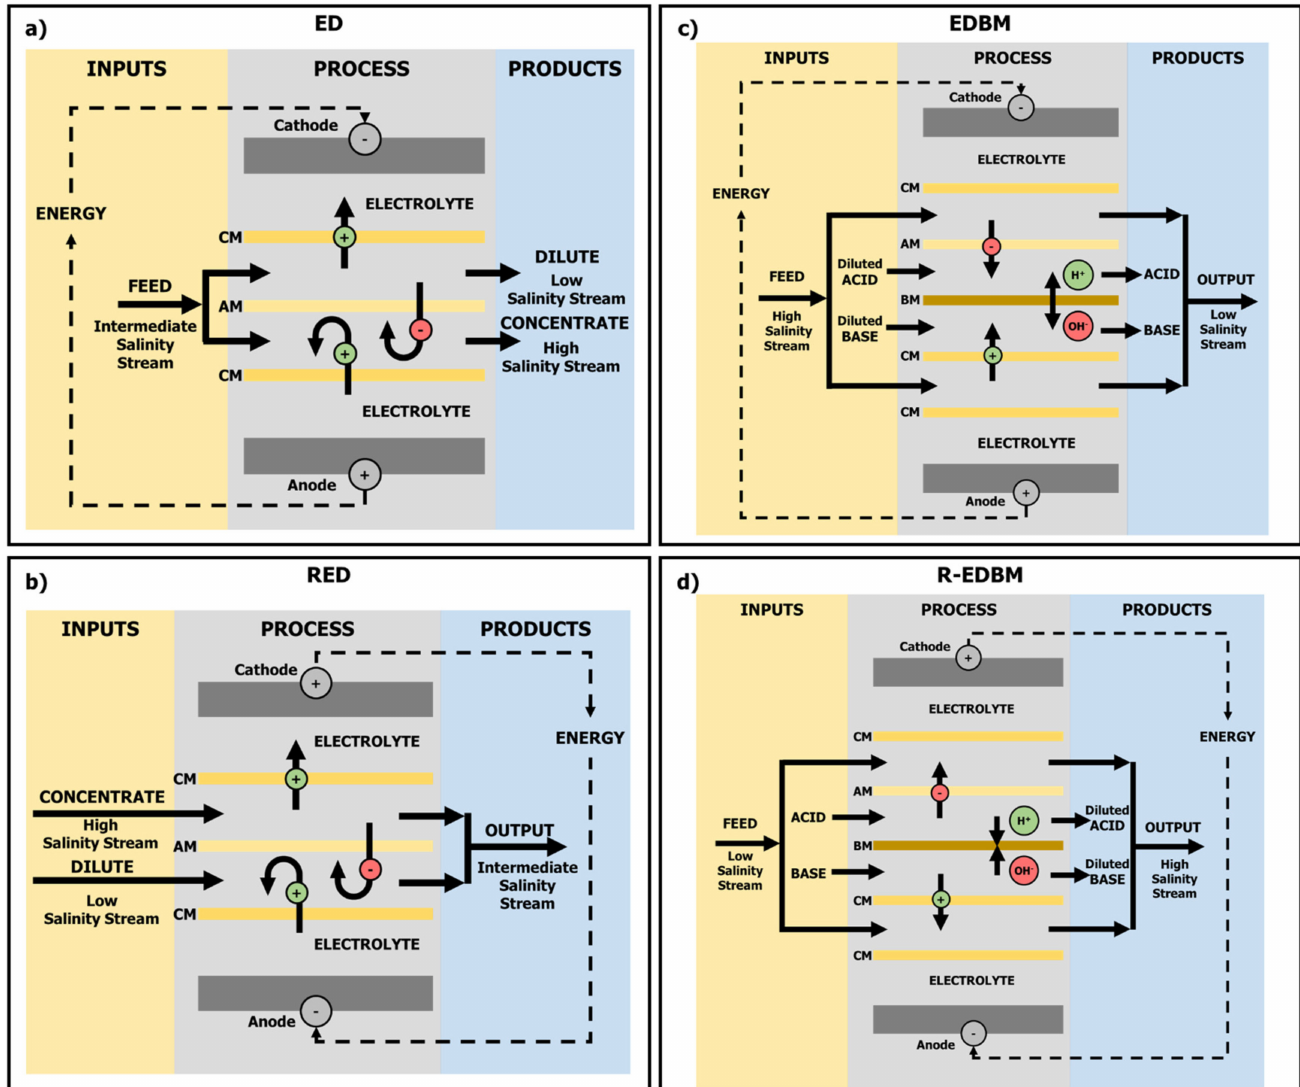
Figure 1. Simplified diagram of the input, process, and products of the electro-membrane processes: ( a ) electrodialysis, ( b ) reverse electrodialysis, ( c ) electrodialysis with bipolar membranes, and ( d ) reverse electrodialysis with bipolar